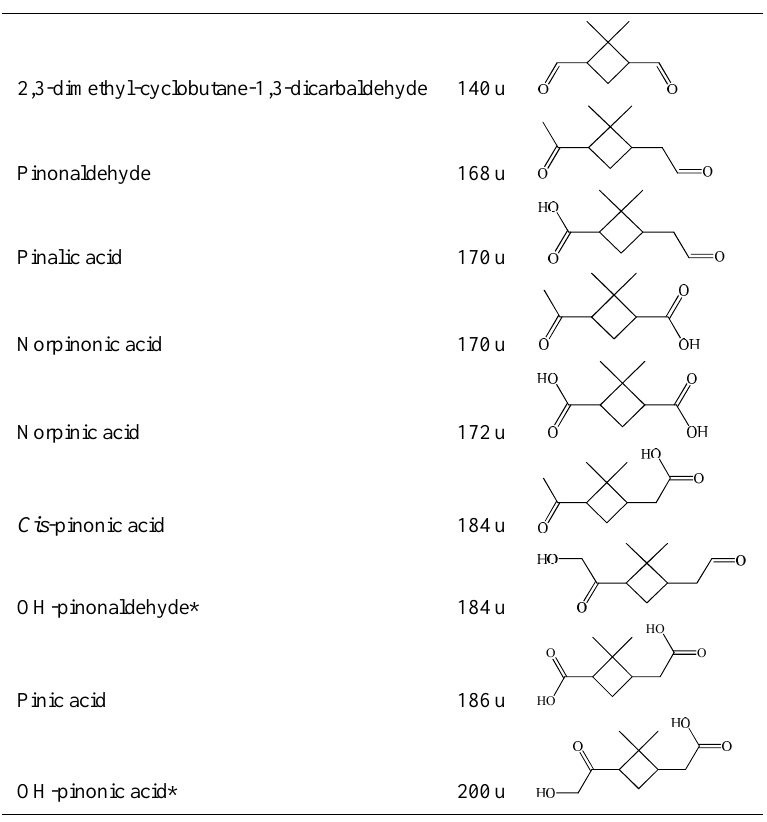
Table 1. Particle-phase products of α -pinene ozonolysis measured by NIR-LDI-AMS as the [M-H] − pseudo-molecular ions. (*) Tentative assignment to one of several possible isomers (see text for further discussion).